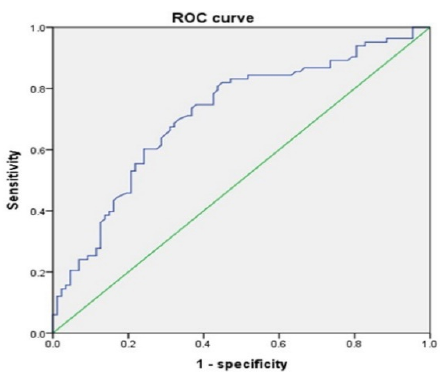
Figure 2. RLA ROC curve.